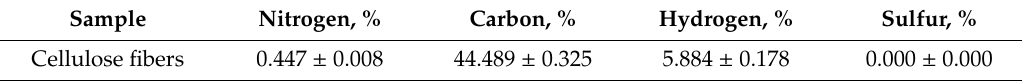
Table 3. Elemental analysis of cellulose fibers discarded by the papermaking